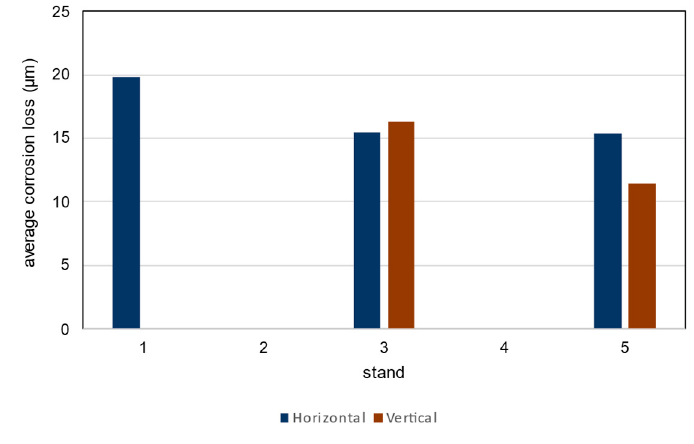
Figure 14. Average corrosion loss after 1 year of exposure.